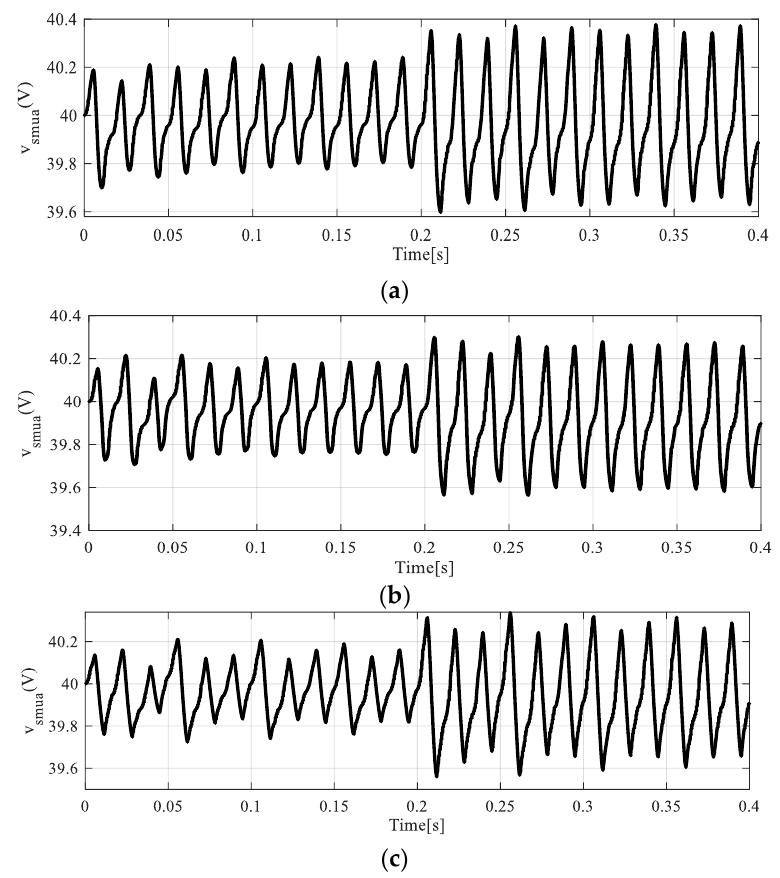
Figure 11. The upper submodule (SM) capacitor voltages of phase “a” for the ( a ) first controller, ( b ) second controller, and ( c ) third controller.